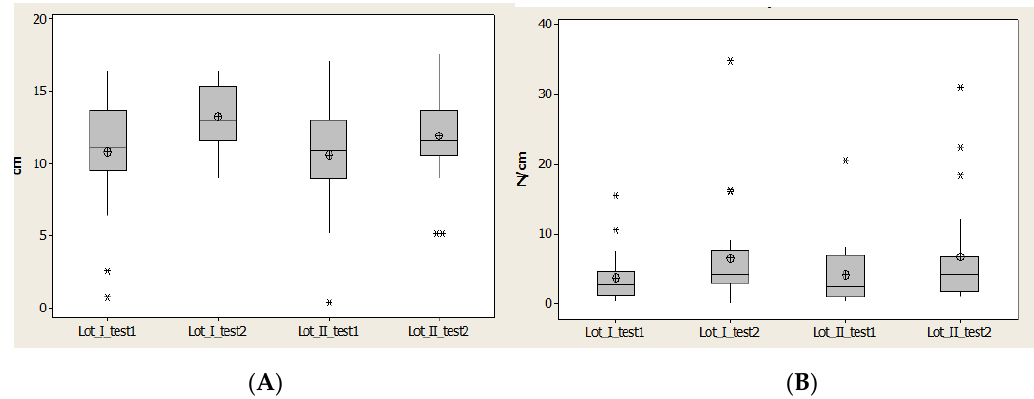
Figure 13. Plantar region Meta 5: ( A ) Contact area, ( B ) Pmax distribution. * Small distribution, ** High distribution Maximal pressure (Pmax) had many values outside of the normal interval. Average and median values between quartile 1 and 3 increased (Figure 13).